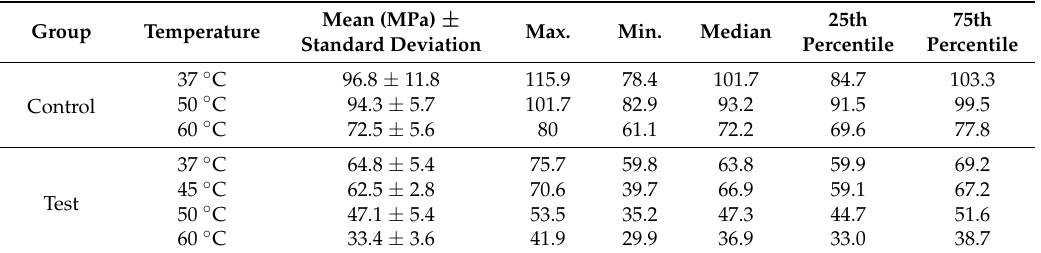
Table 1. Compressive strength (MPa) of both control and test groups at different temperatures (37 °C, 50 °C and 60 °C).